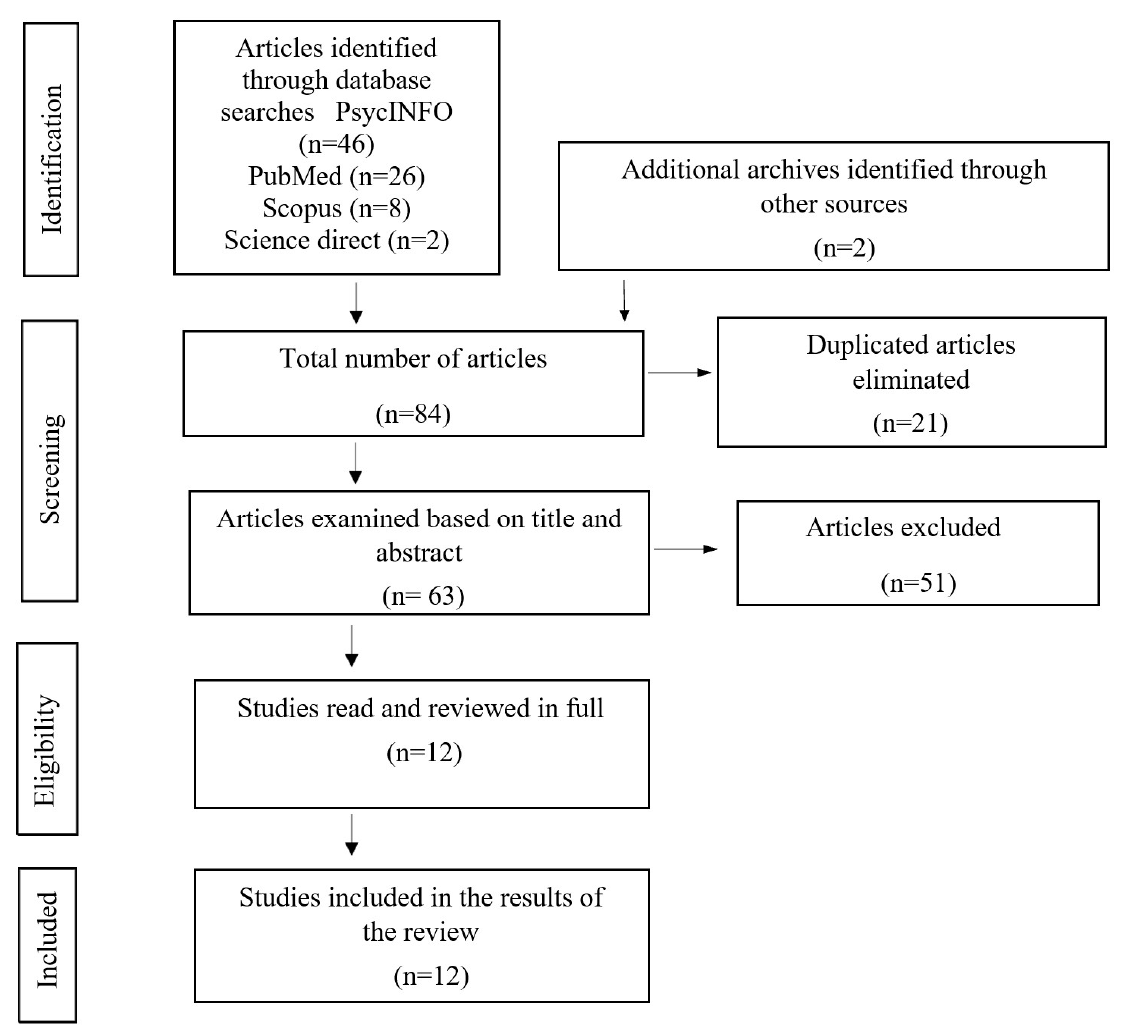
Figure 1. Preferred Reporting Items for Systematic Reviews and Meta-Analysis (PRISMA) flow diagram of each stage of the study selection.